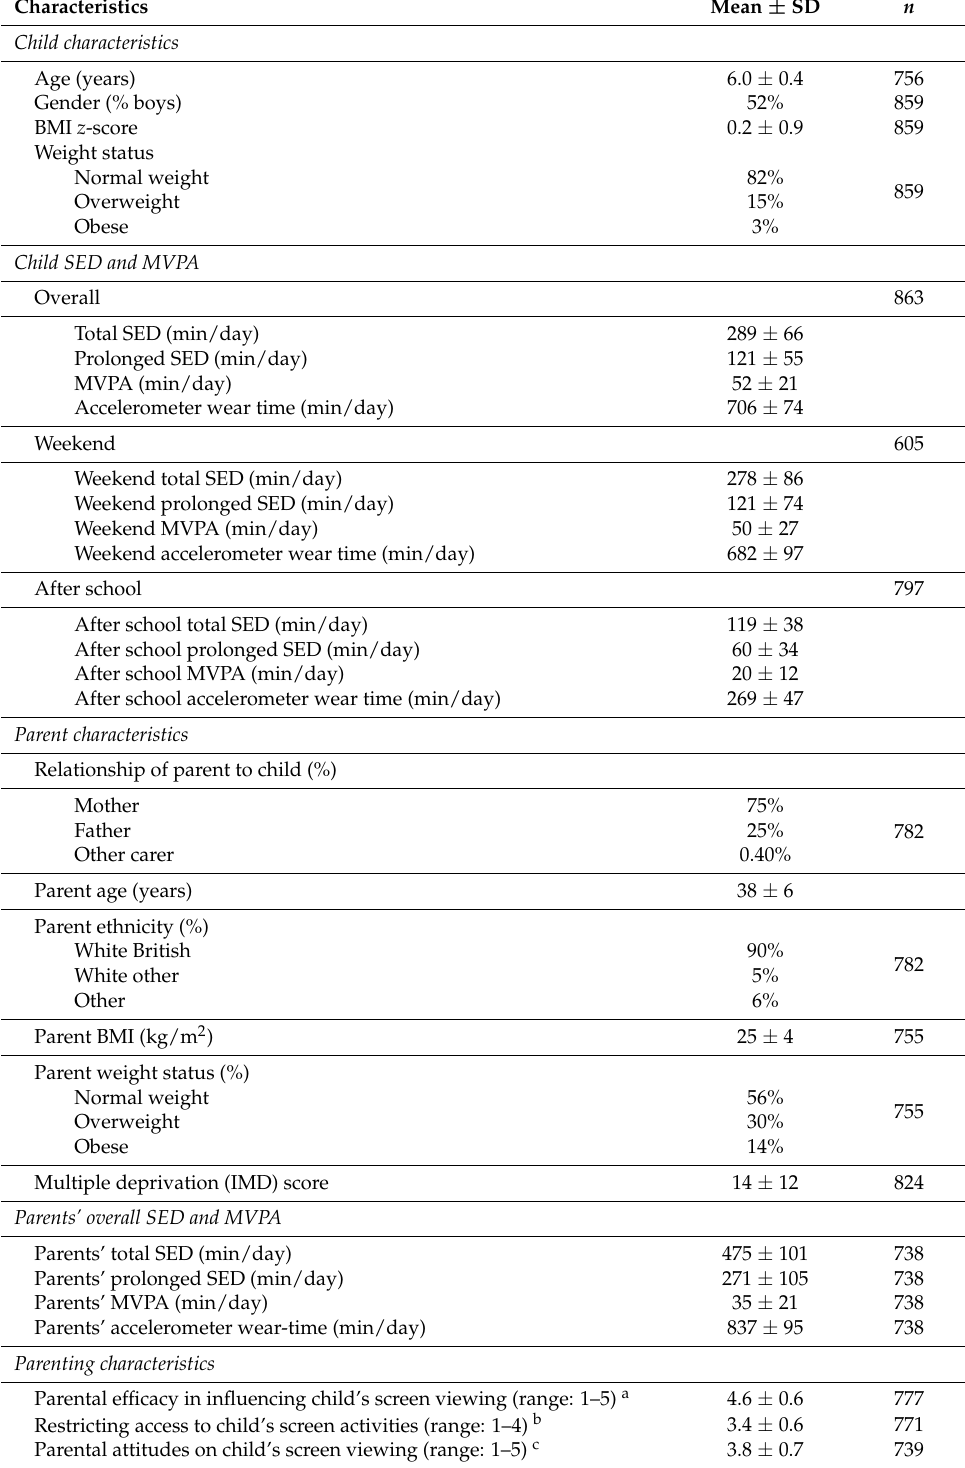
Table 2. Characteristics of 5- to 6-year-old children and their